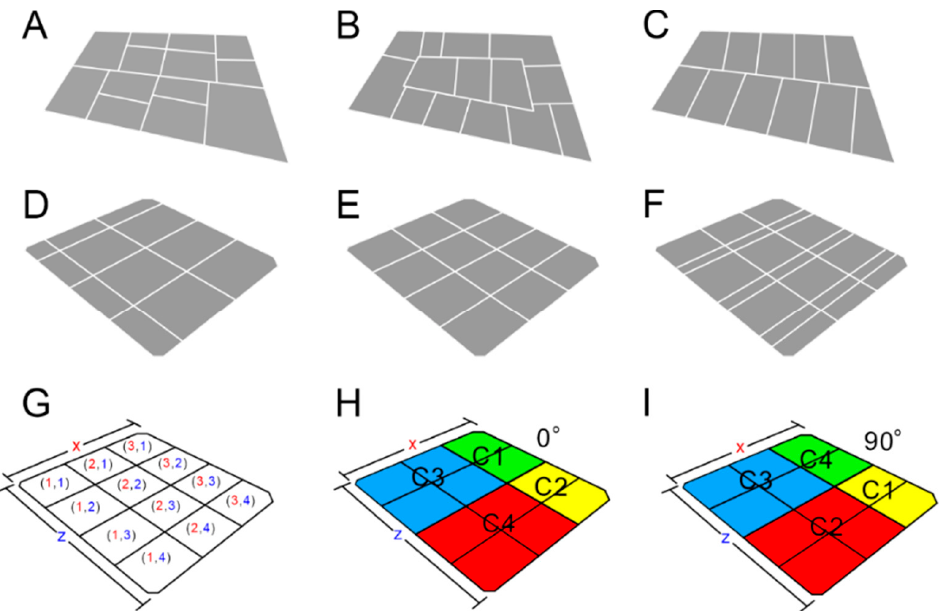
Figure 3. Parcel subdivision, clustering, and rotation (( A – C ) showing subdivision results generated by recursive, offset, and skeleton algorithm; ( D – F ) showing subdivision results generated by partition algorithm with absolute values, specified partition number, and specified ratio; ( G ) showing index of inner lots, ( H ) showing inner lots clustered based on their index, ( I ) showing cluster lots rotating as a whole).